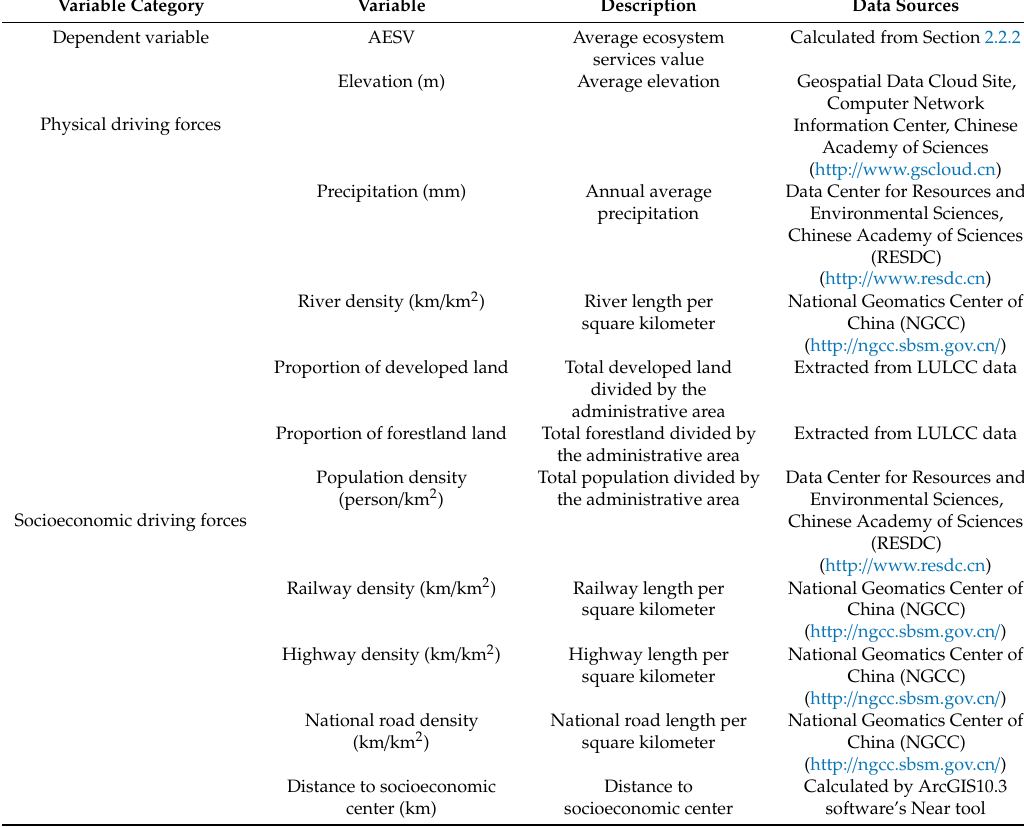
Table 4. Variable descriptions and data